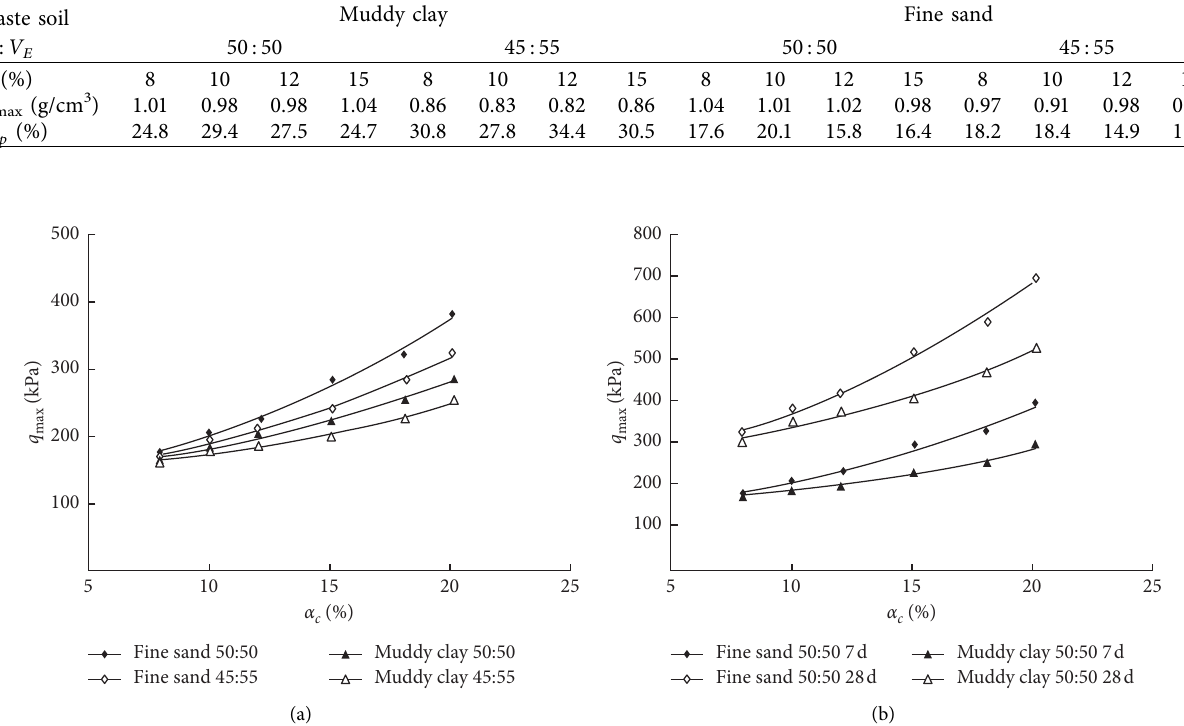
Figure 3: Unconfined compressive strength for (a) different volume ratios and (b) curing times.